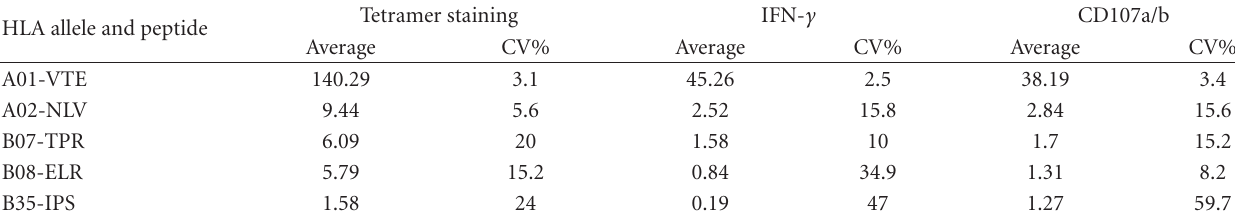
Table 2: Precision within